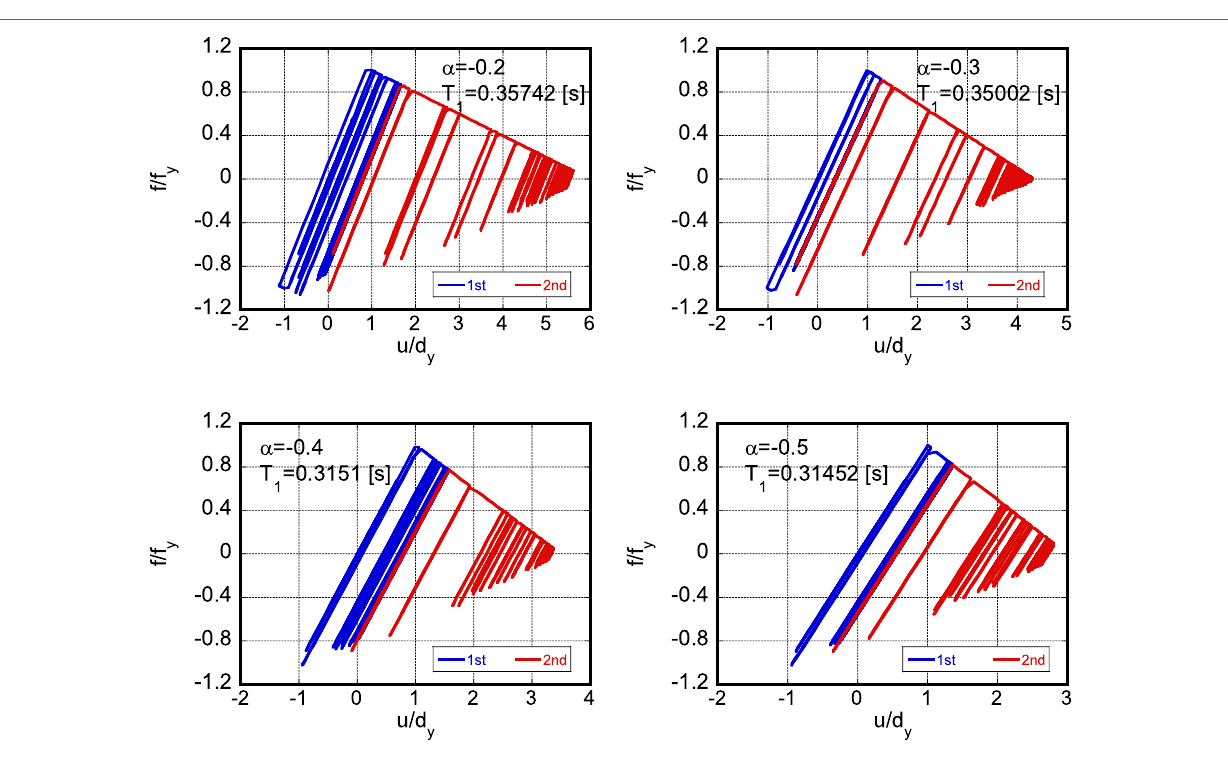
Fr ontiers in Built Environment |